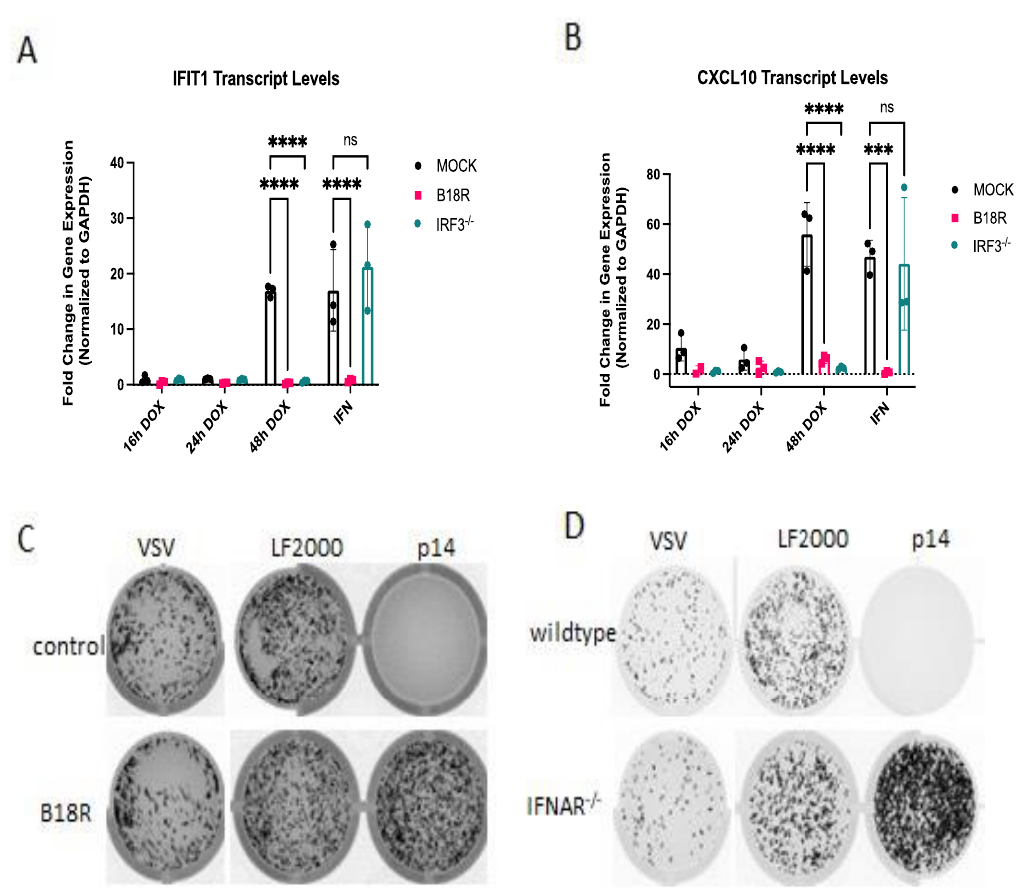
Figure 7. The antiviral responses to endogenously or exogenously delivered p14 requires IRF3 and IFN-I. ( A , B ) Wildtype or IRF3 − / − THF cells expressing p14 under a doxycycline-inducible promoter were treated with doxycycline for the indicated time and the IFN-blocking antibody B18R where indicated; then, RNA was harvested for qRT-PCR to detect ( A ) IFIT1 or ( B ) CXCL10 transcripts. ( C ) Wildtype THF cells were pretreated with B18R (200ng/mL) to block IFN, or ( D ) wildtype and IFNAR − / − cells were not pretreated and then were transfected with p14/LF2000 and subsequently challenged with VSV-GFP 16 h post treatment. Groups were compared by one-way ANOVA (*** for p < 0.001 and **** for p <